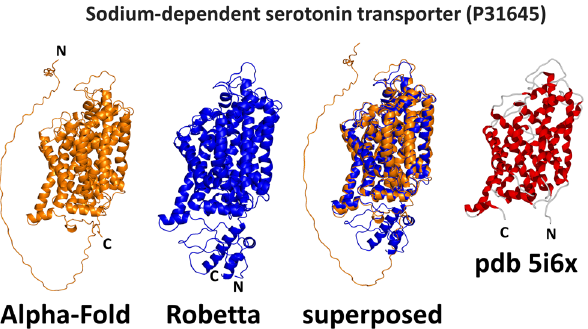
Figure 4: Comparison of AlphaFold, Robetta, and X - ray ( pdb 5i6x ) models for sodium - dependent serotonin transporter. The N - and C - terminus is indicated for all models.